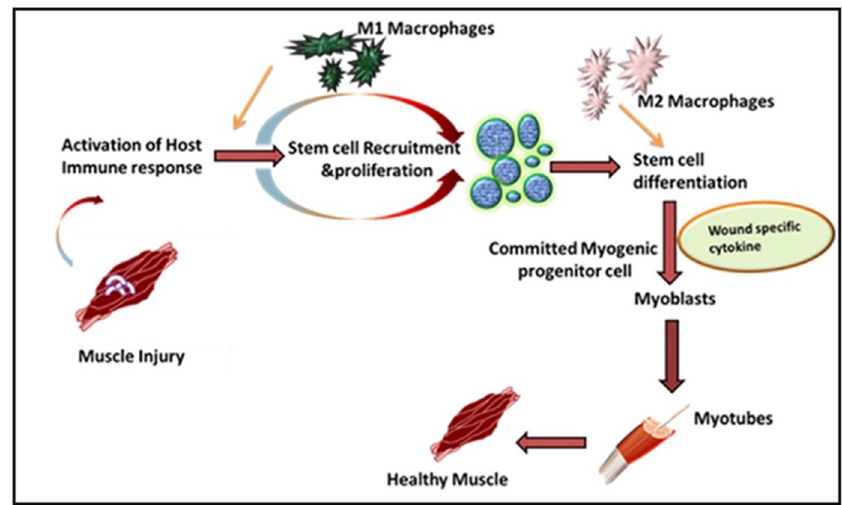
Figure 1. Immune response in VML : In mild or severe injury the host immune response is activated. The tissue-resident stem cells are recruited at the site and their proliferation begins. M1 and M2 macrophages are activated which clear the damage and repair the tissue and fibrosis D.